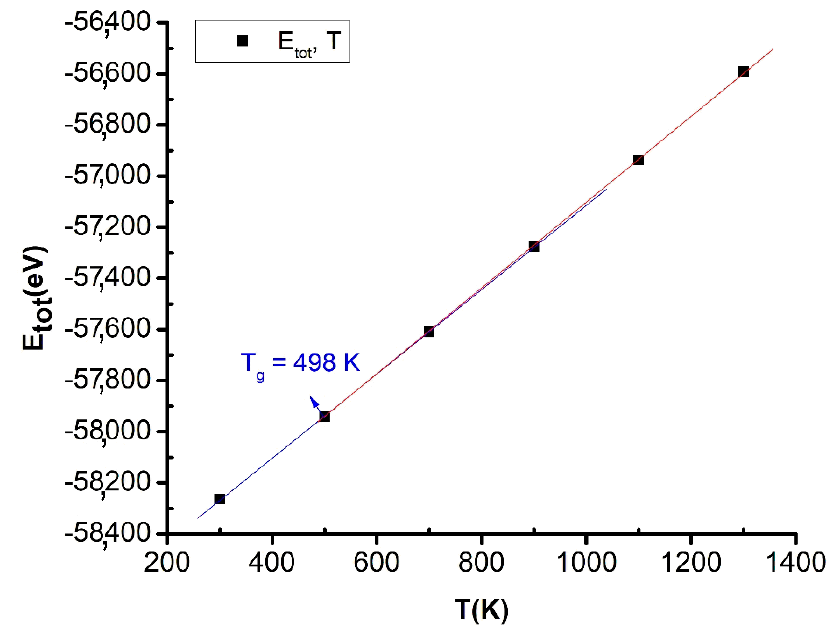
Figure 4. Phase transition of Fe 63 Ni 32 Co 5 alloy in the function of the temperature.